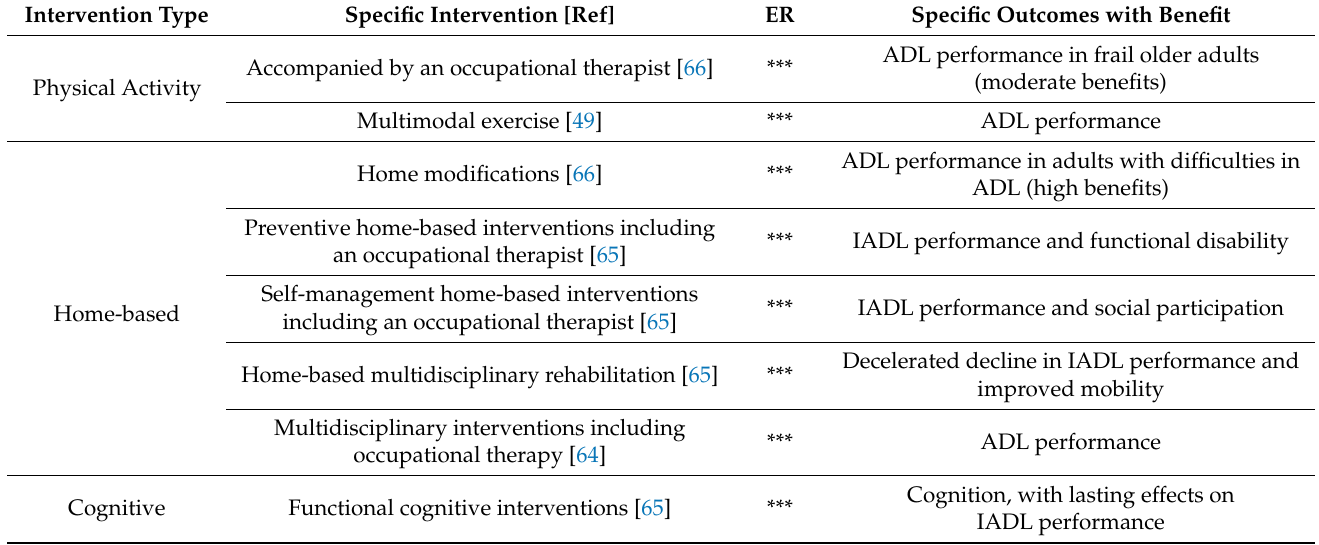
Table 6. Identified interventions for Activities of Daily Living and Instrumental Activities of Daily